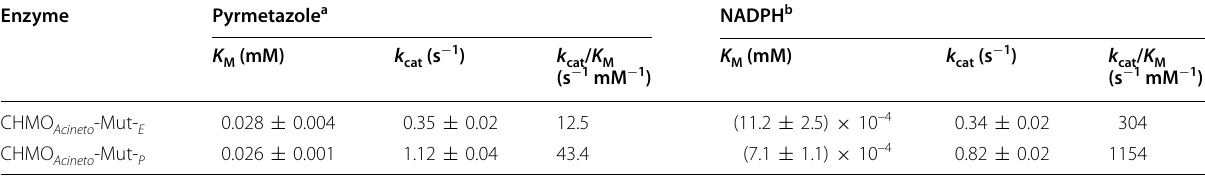
a Kinetic parameters were determined in 0.5 mL reaction scale which contained potassium phosphate (100 mM, pH 9.0), methanol (2%, v/v), various concentrations of pyrmetazole (2–400 μM), NADPH (200 μM) and appropriate amount of CHMO Acineto -Mut b Reactions were determined by employing pyrmetazole (200 μM) and various concentrations of NADPH (5–200 μM). For detailed analytical conditions, see experimental sections